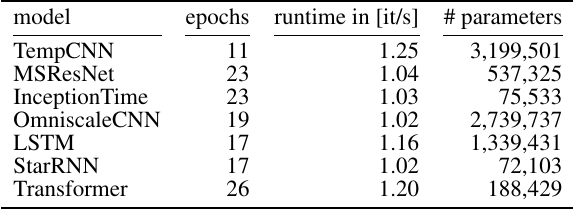
Table 1. Model parameters and runtime in iterations per second on a P100-GPU with a batch size of